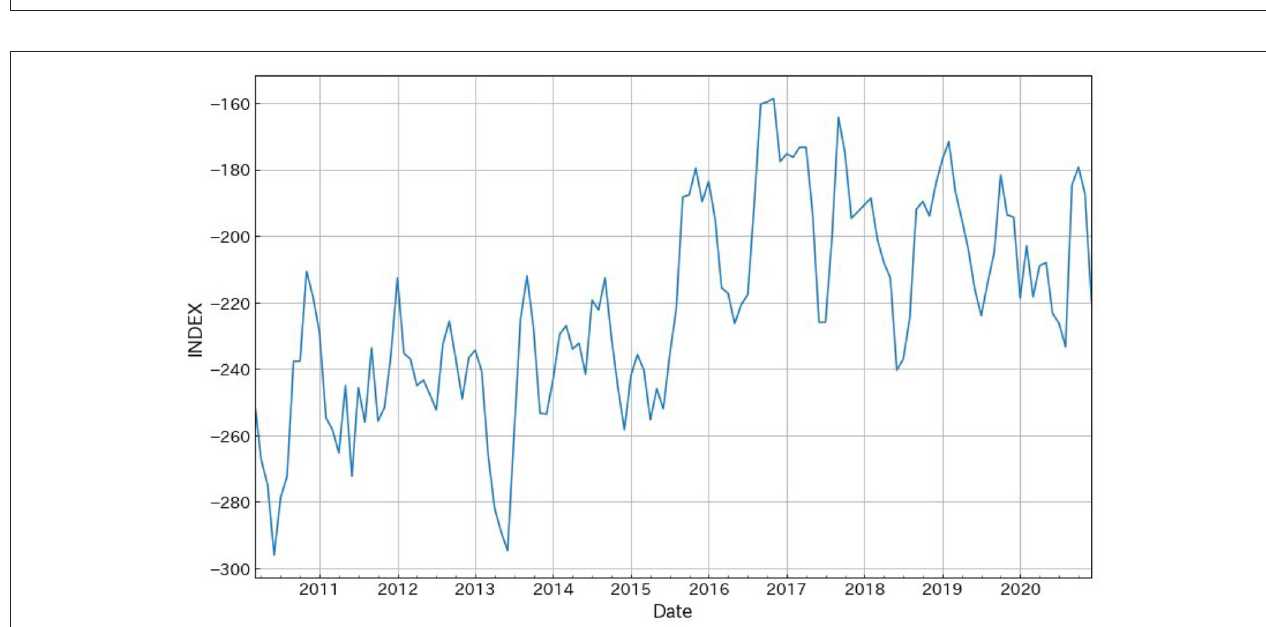
FIGURE 5 | Example of investment simulations.